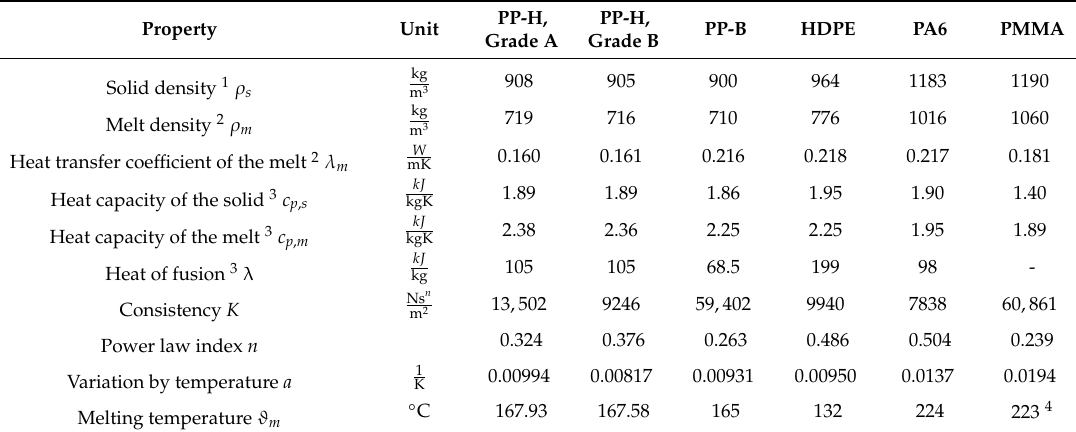
Table 4. Characteristics of the materials used.